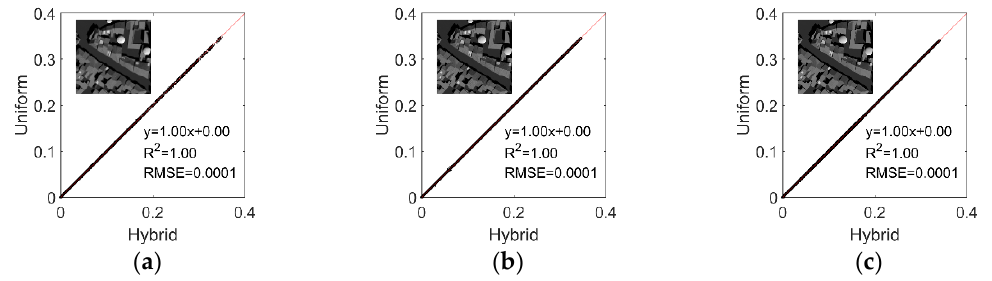
Figure 9. Accuracy comparison of the hybrid and uniform approaches when simulating remote sensing images of Basel at three spatial resolutions: ( a ) 1 m, ( b ) 0.5 m and ( c ) 0.25 m. Table 1. Computational resources used by simulating the BASEL scene with different approaches.